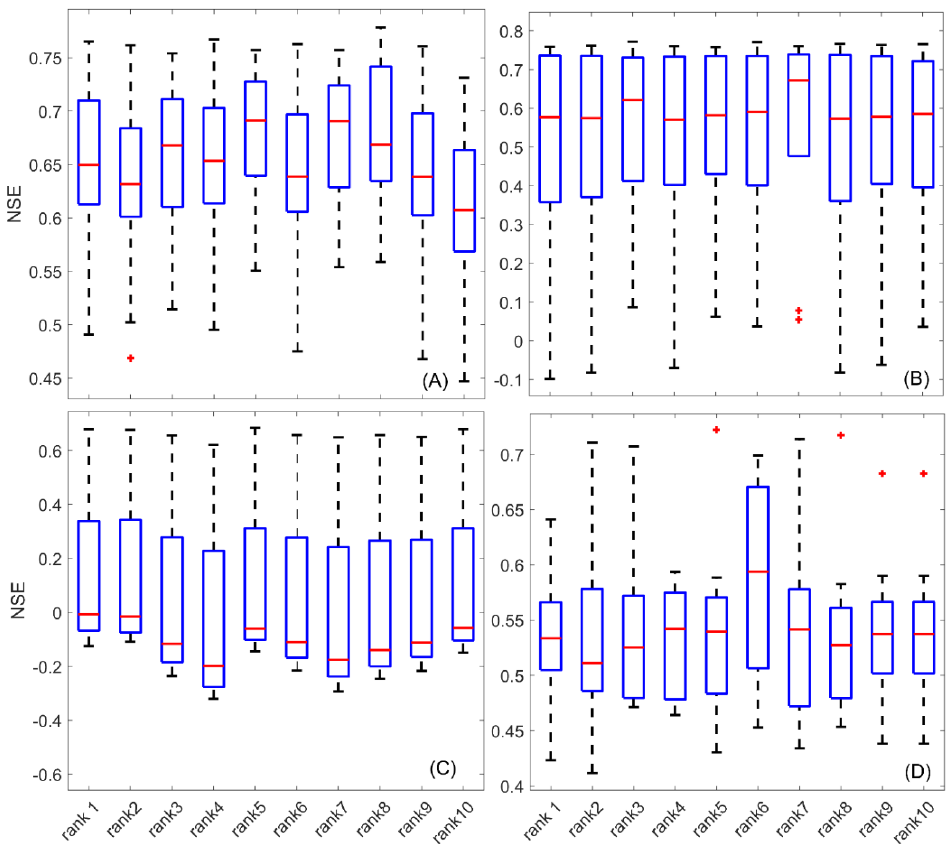
Figure 8. Distributions of NSEs based on the daily SWE during 2001–2007 (calculated by evaluating the sub-watershed scale daily SWE predictions from the best 10 sets of parameters with the Parallel Balance Model (ParBal) SWE reconstruction product). ( A – D ) Correspond to the Kings, Kern, Tule, and Kaweah watersheds, respectively. NSE refers to the Nash-Sutcliffe Efficiency.